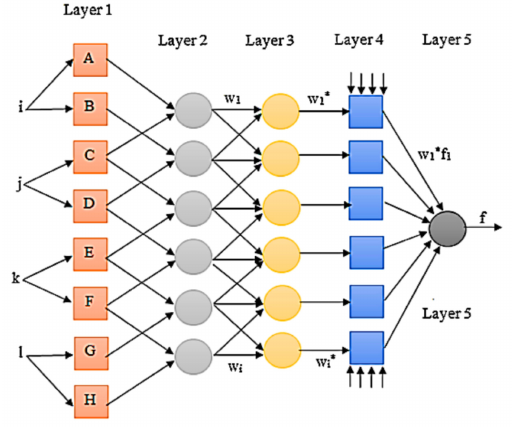
Figure 5. Adaptive neuro-fuzzy inference system (ANFIS)